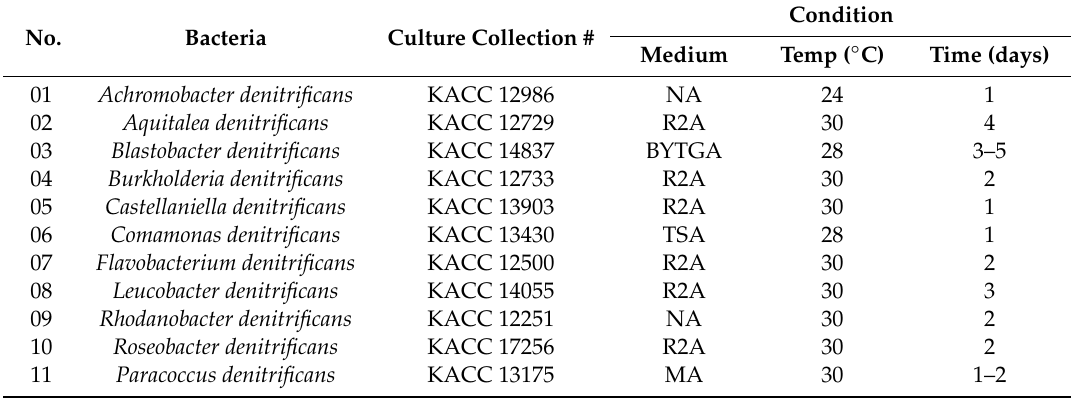
Table 1. Information regarding the collected denitrification